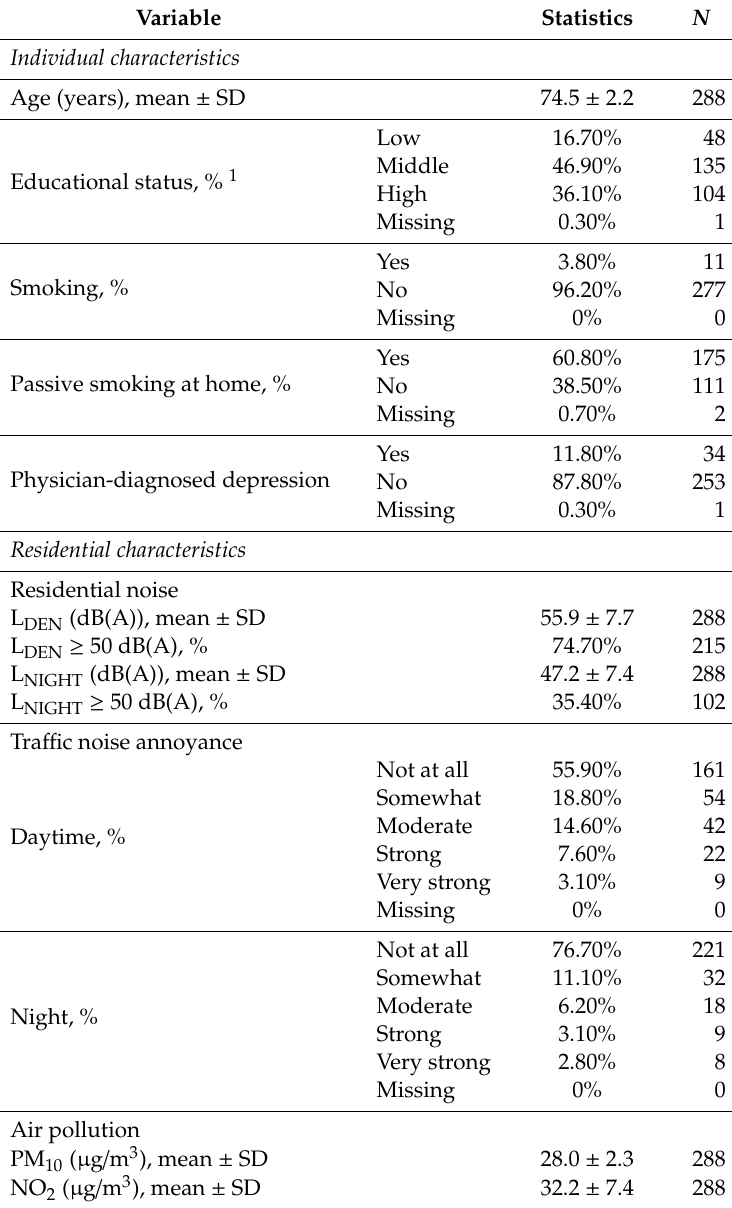
Table 2. Individual and residential characteristics of the analysis